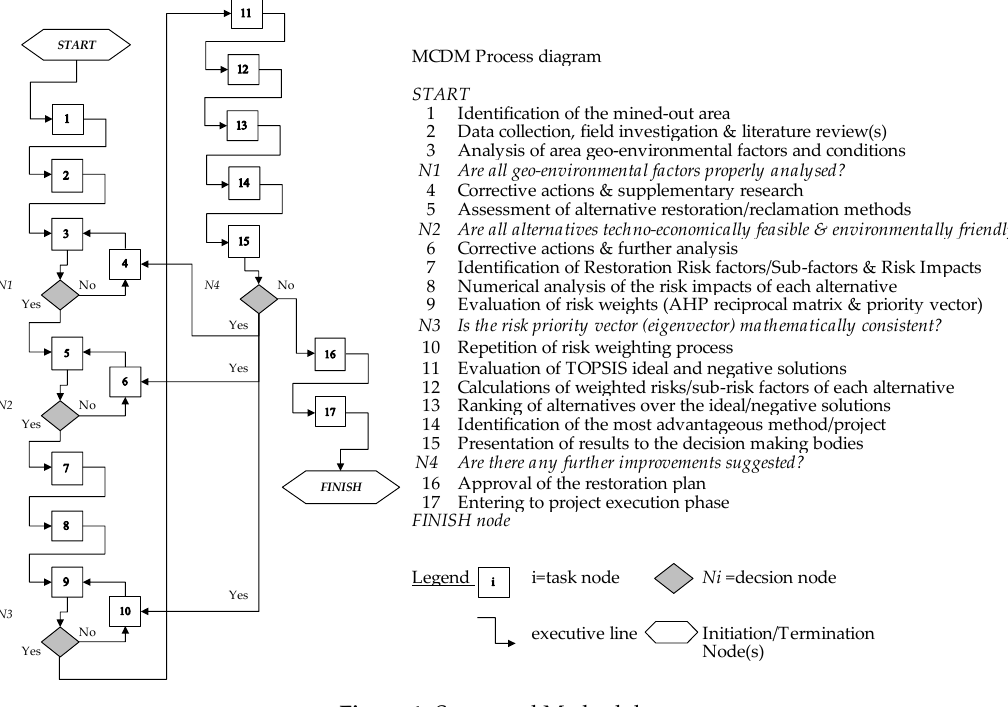
Figure 1. Suggested Methodology.